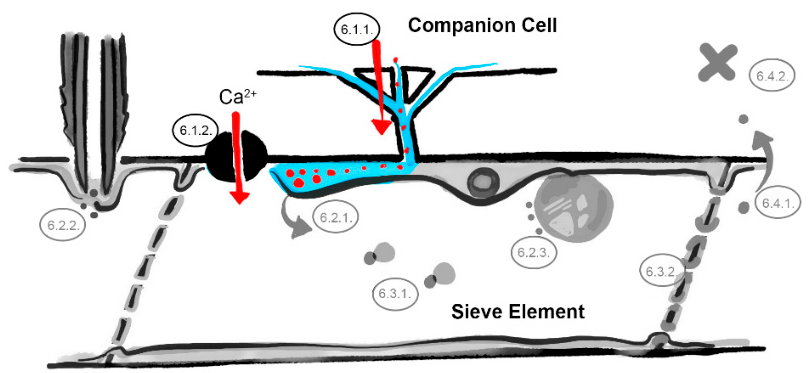
Figure 2. The companion cell–sieve element interface barrier. Restricted transport of viruses through plasmodesmata pore units (Section 6.1.1) and influx of ions and loading of defense molecules (Section 6.1.2). Involved barriers are indicated in color (light blue = sieve element reticulum, red dots = virus identities, black = ion channel, numbers correspond to the listed mechanisms in the main text, image not drawn to scale).